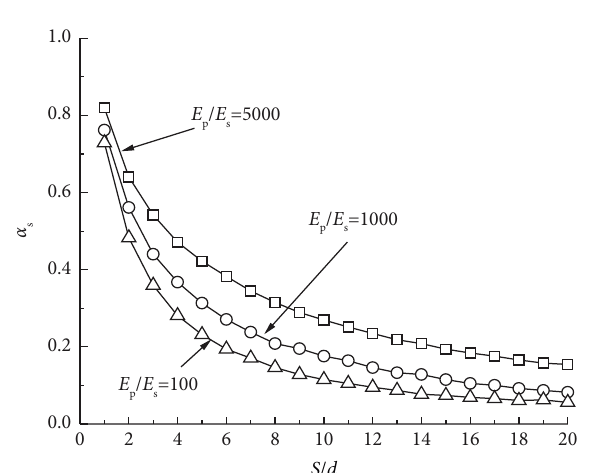
Figure 13: Infuence of the pile-soil elastic modulus ratio E interaction factor α s .